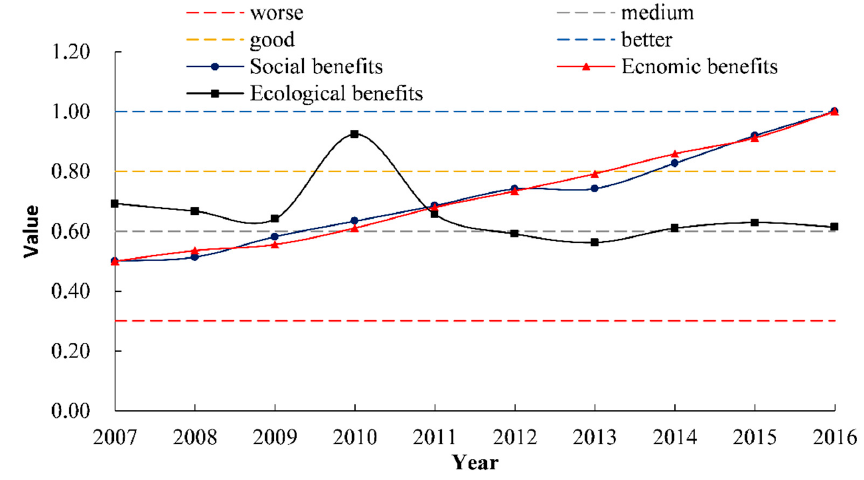
Figure 4. Trends in the performance of target layers.